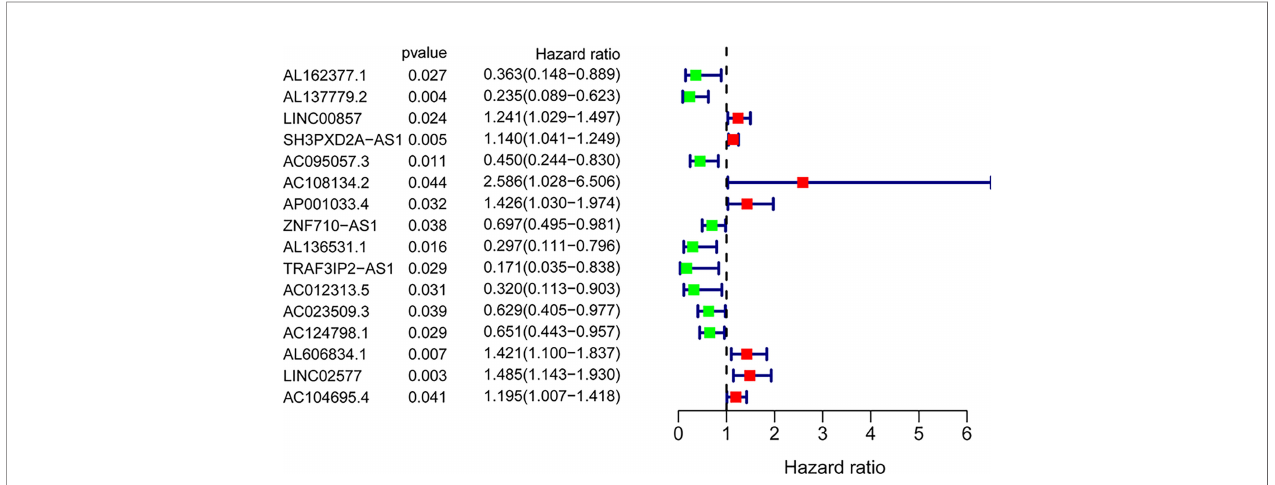
FIGURE 3 | Forest plot of 16 GInLncRNAs associated with overall survival of patients based on univariate Cox regression